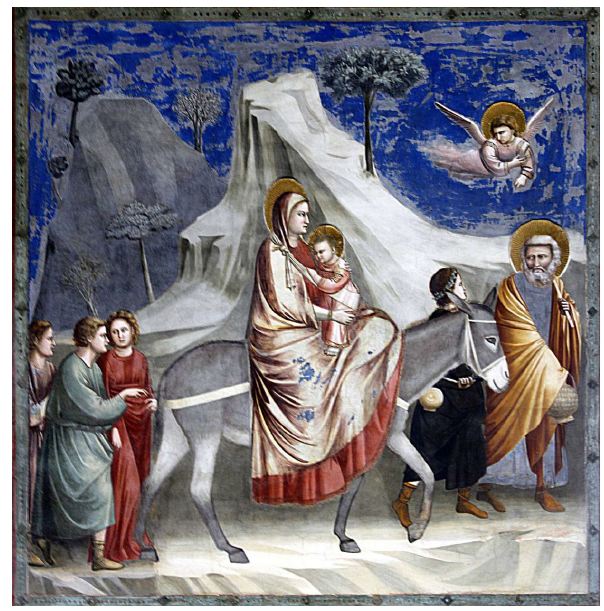
Figure 15. The flight into Egypt by Giotto (1304–1306). Scrovegni (Arena) Chapel, Padua, Italy. Source: public domain – Wiki Com-